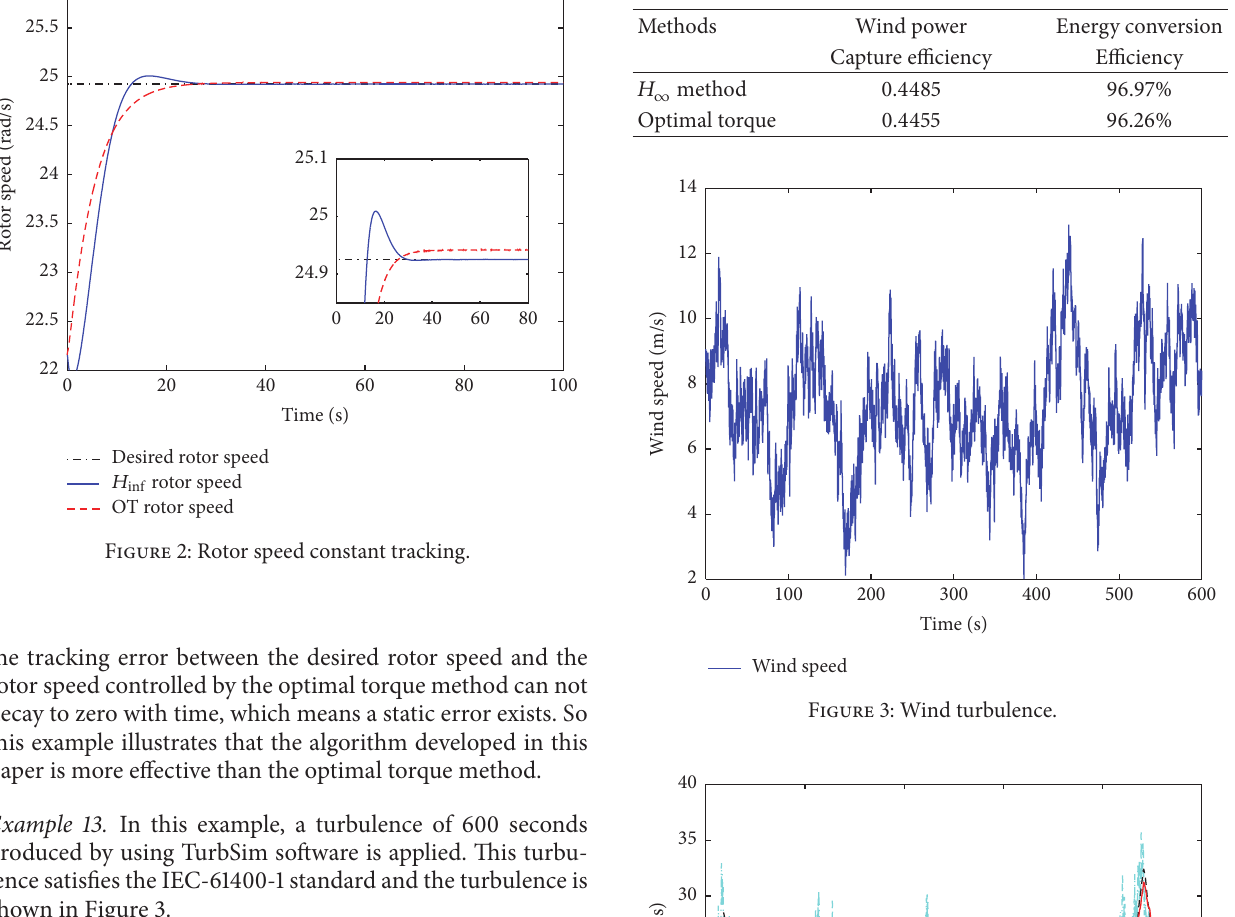
Table 2: Compared power conversion efficiency.